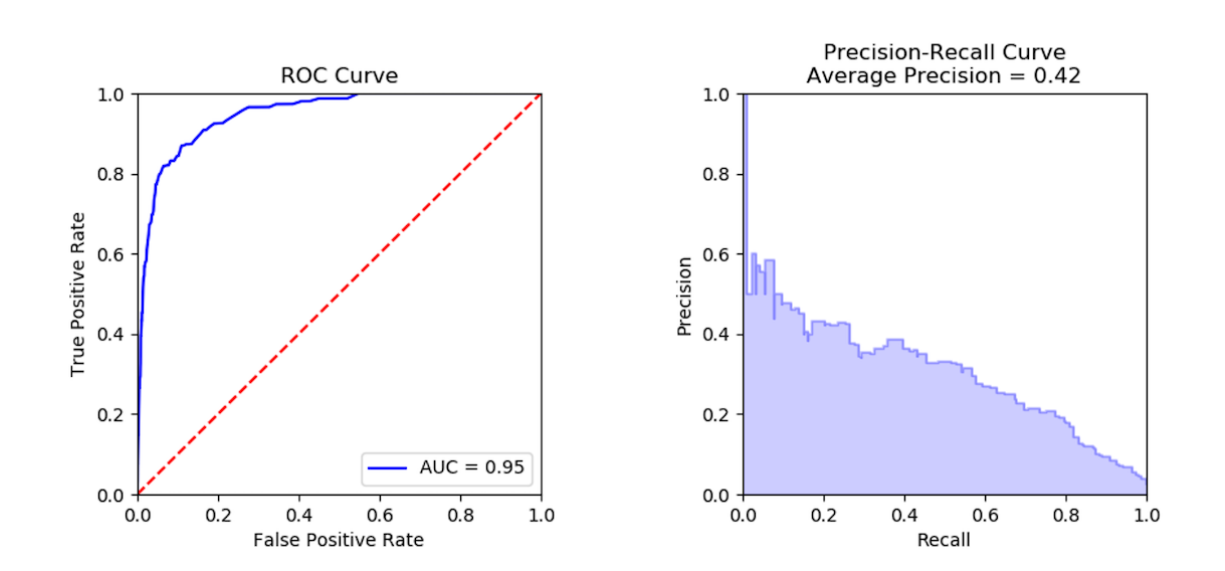
The correction will appear in the online version of the paper on to PubMed, PubMed Central, and other full-text repositories, the corrected article has also been resubmitted to those